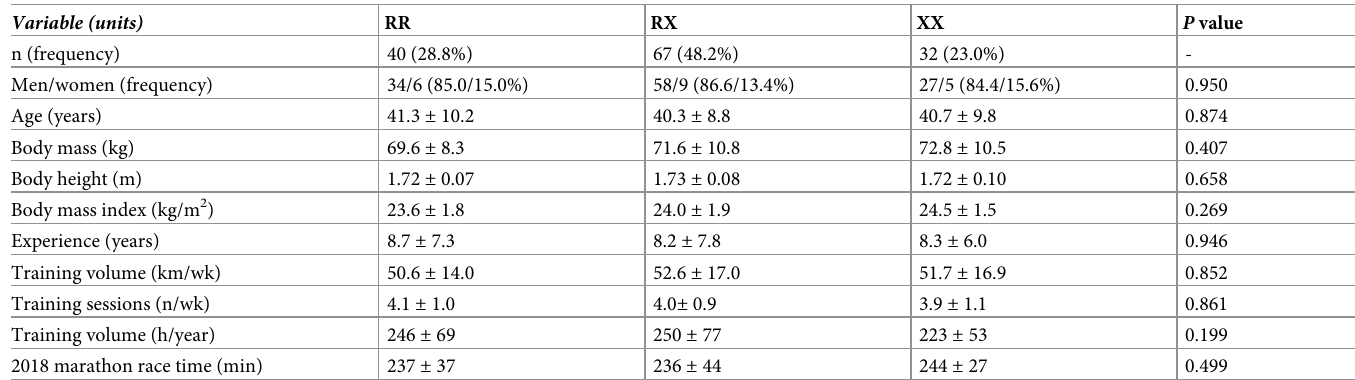
Table 1. Age, anthropometric characteristics, running experience and training status of marathoners with different ACTN3 R577X genotypes. Data are mean ± SD. Variable